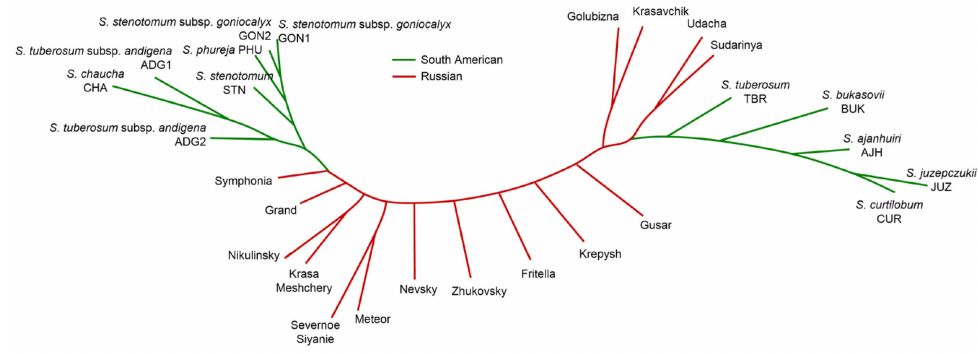
Figure 6. Tree diagram reconstructed by potato genomes using their CNV similarity. Cultivars from Russia are shown by red branch color and South American potato accessions shown by green branch